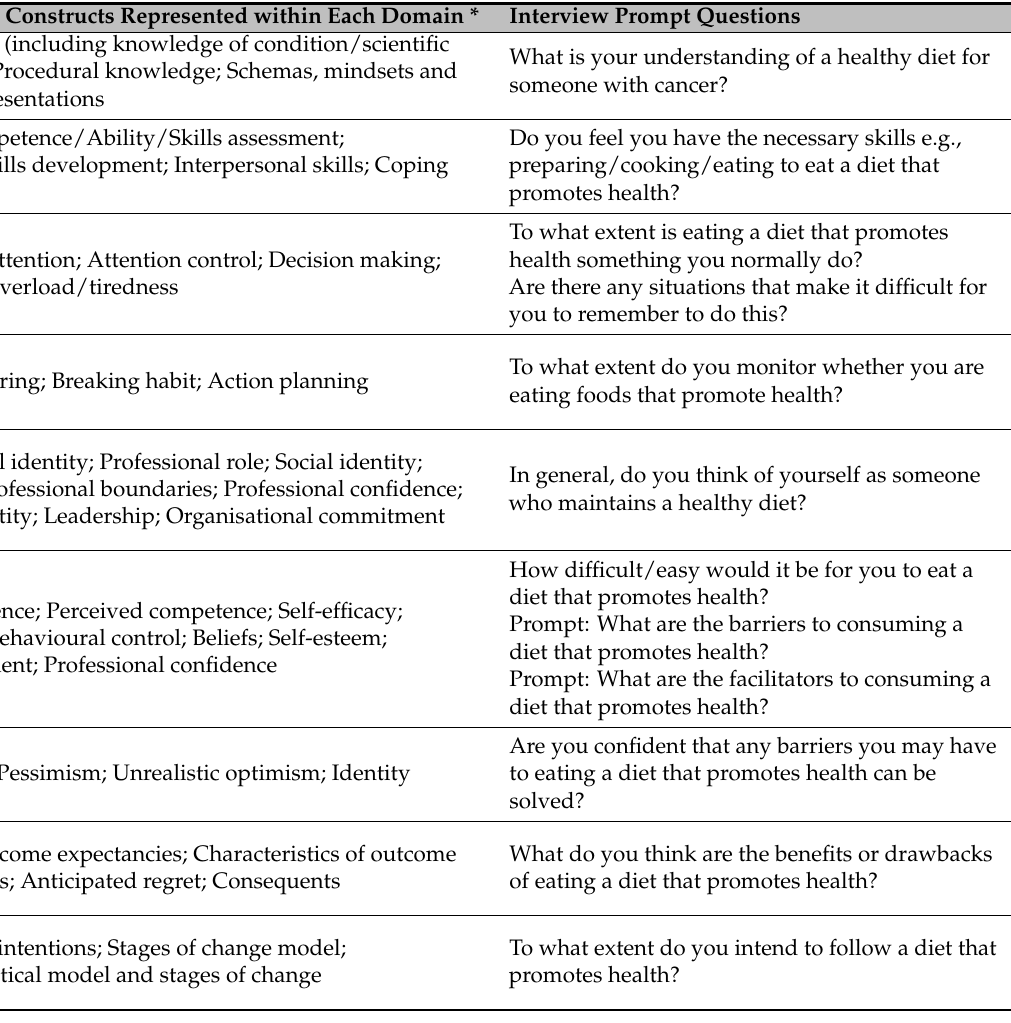
Table 1. Interview prompt questions based on the Theoretical Domains